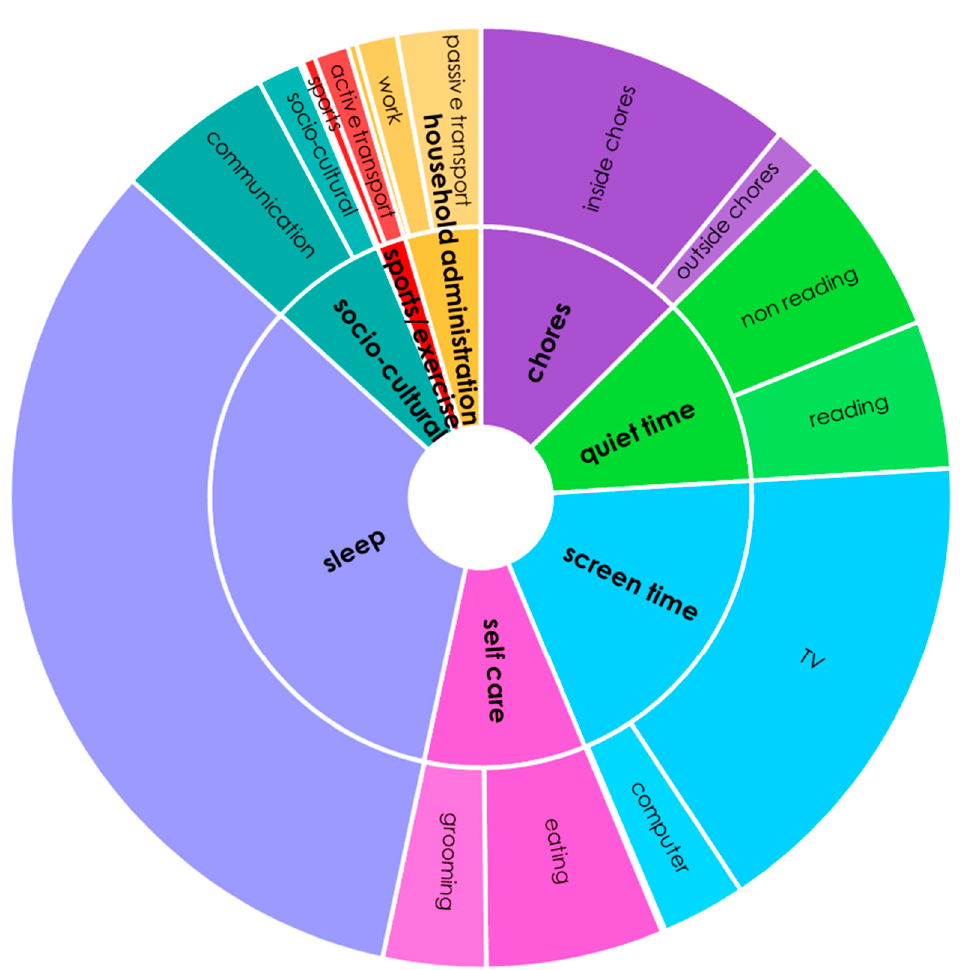
Figure 2. Composite activity profile presenting a typical profile of 24-h time use. Mean time spent in MARCA superdomains (in min/d) is presented using arithmetic means from baseline MARCA data.